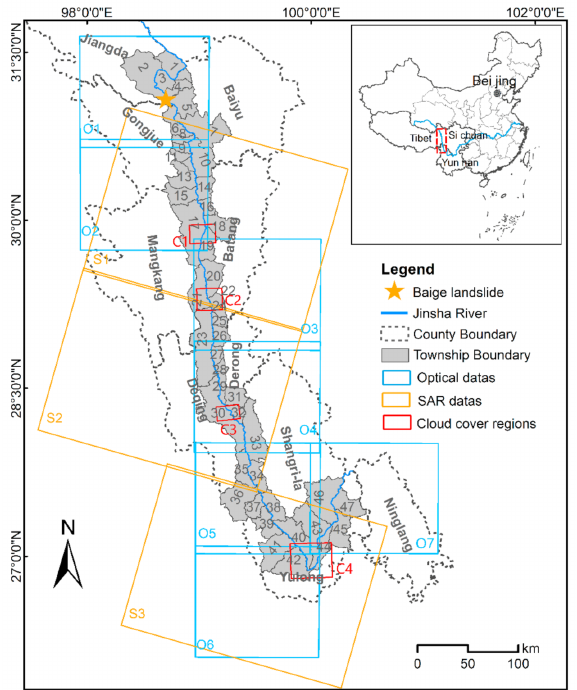
Figure 1. Study area location and image range (Number indicates township code. NO 2, 17, 39 and 42 correspond to Bo luo country, Zhu balong country, Ju dian country, and Shi gu country,